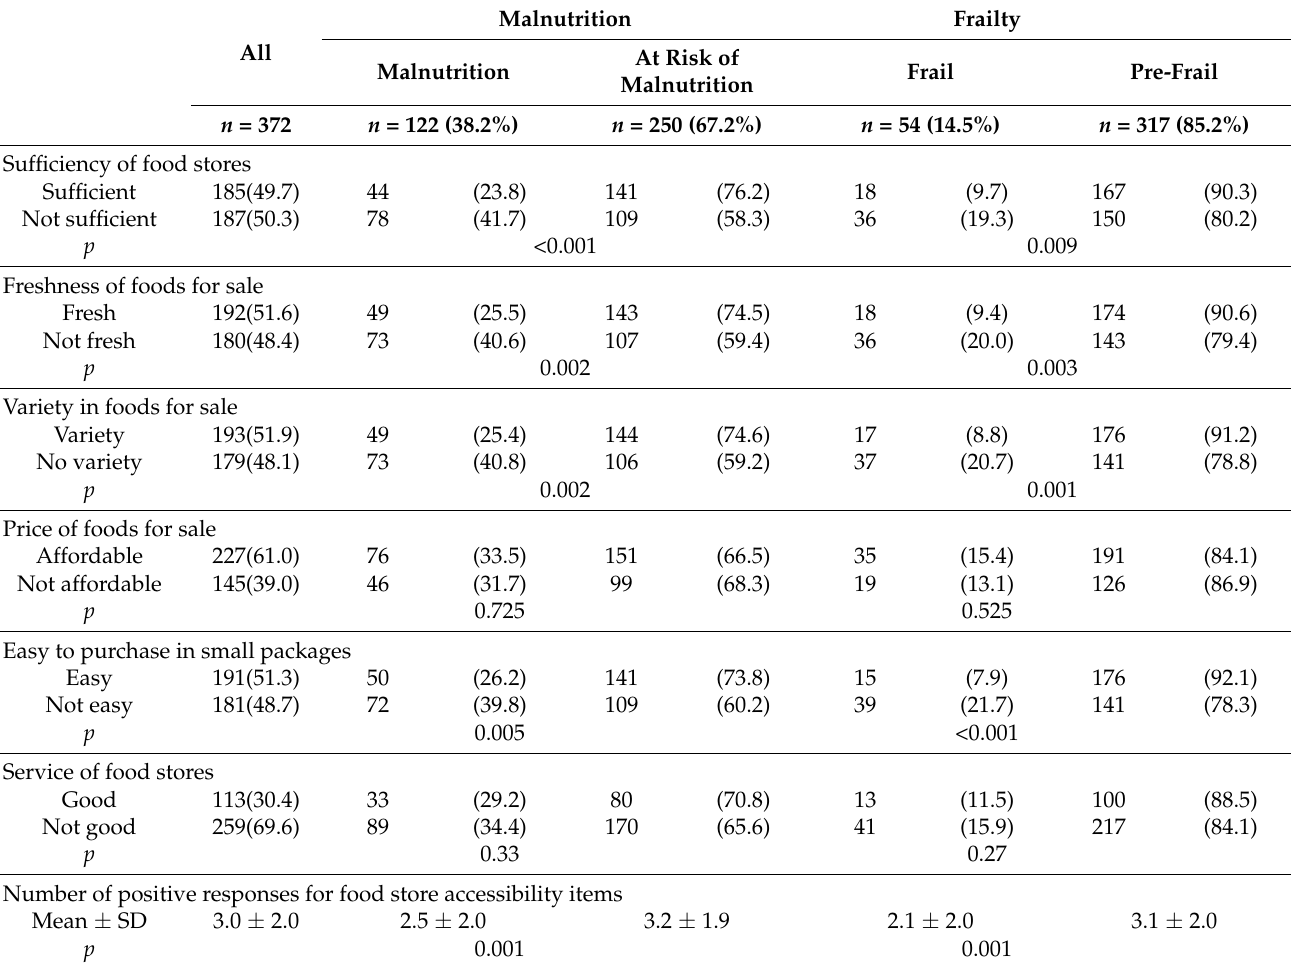
Table 3. Univariate relationship of food store accessibility perception with malnutrition and